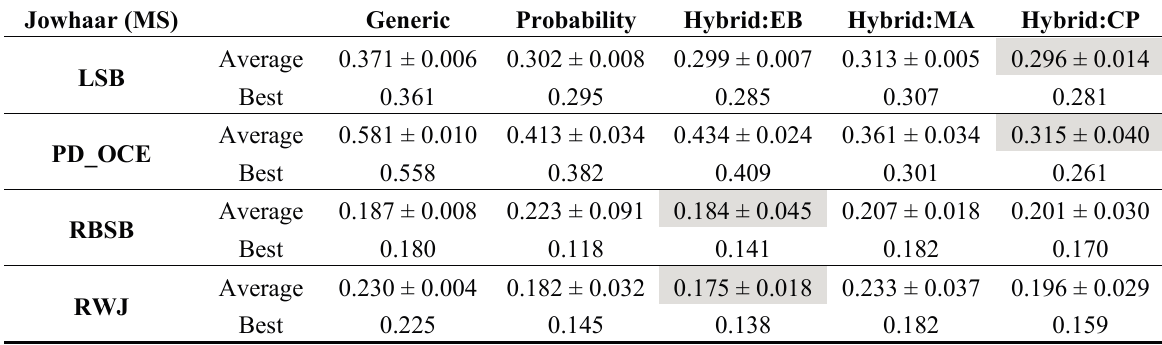
Table 4. Segmentation accuracies achieved in the Jowhaar problem instance. The shaded cells highlight the results of the best performing hybridization strategy.